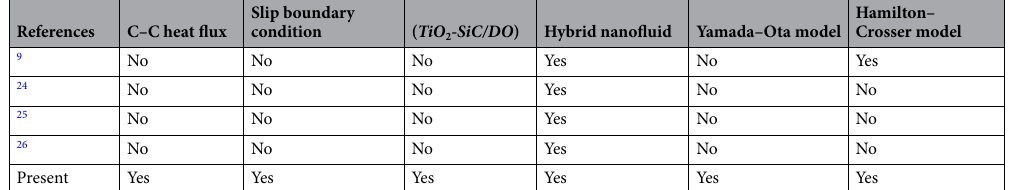
Table 1. Comparison of the current work with the closely related published papers.